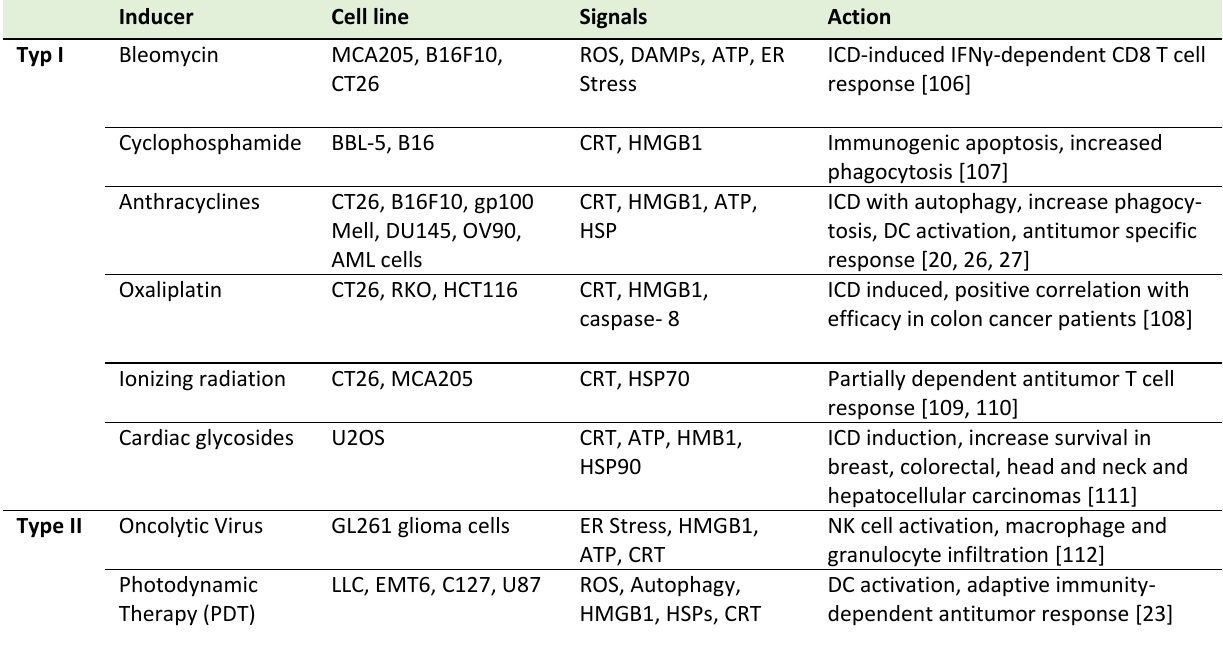
Table 1. Classical ICD